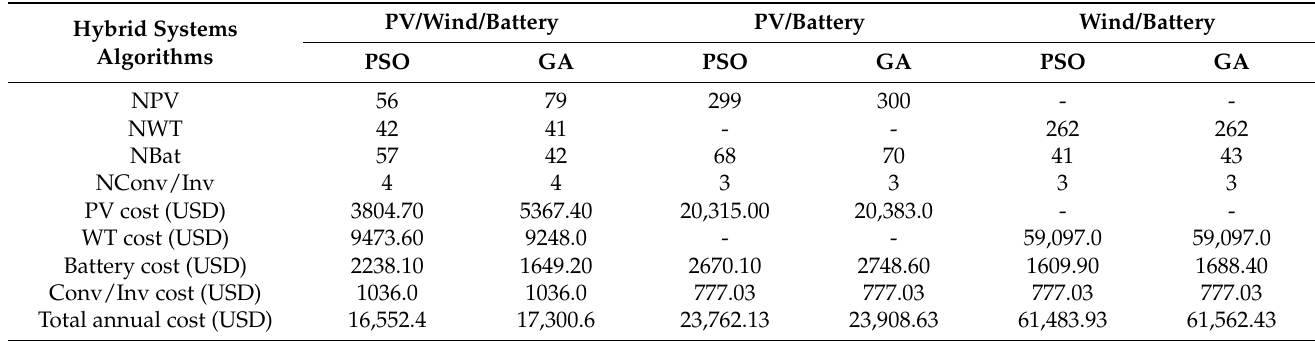
Table 7. Results of optimal sizing for